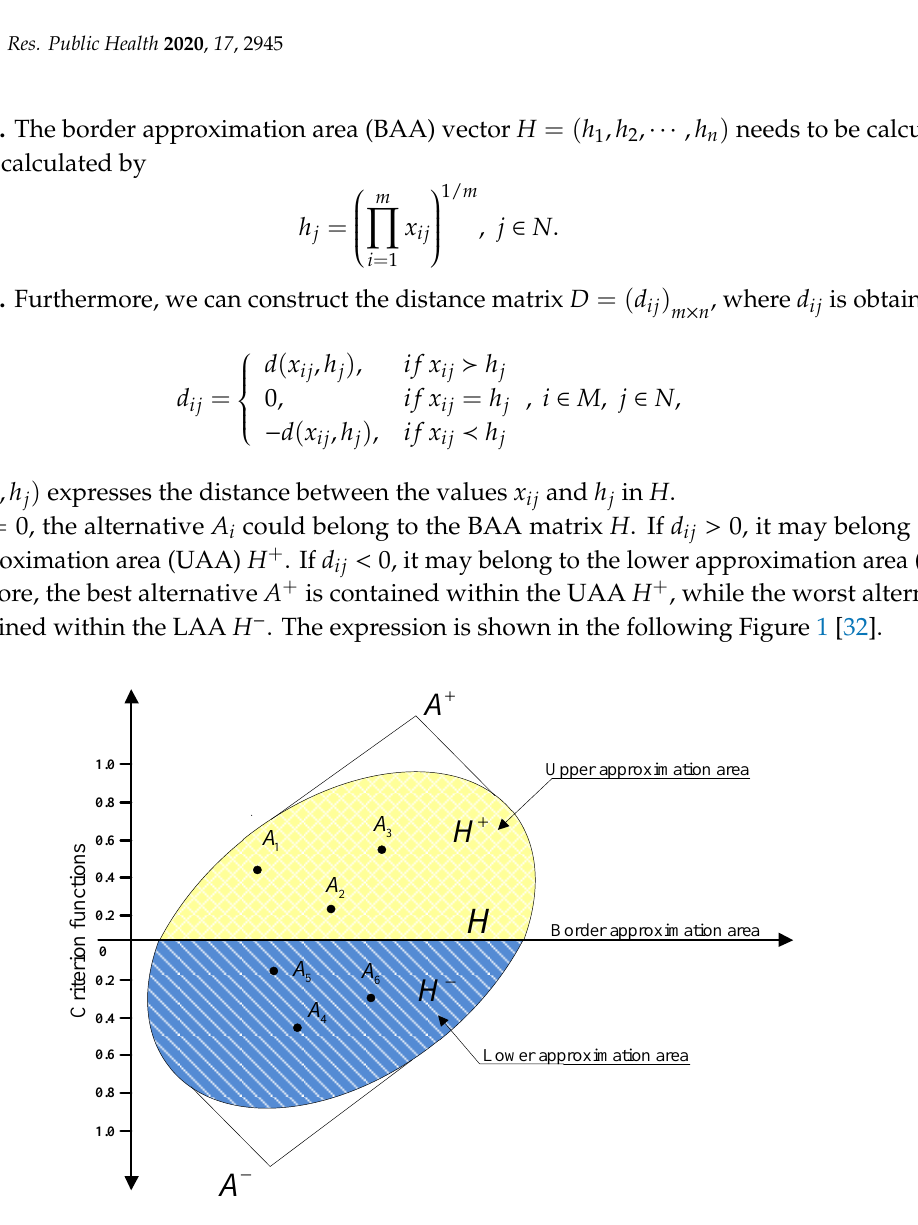
Figure 1. Presentation of the upper ( + H ), lower ( H ) and border ( H ) approximation areas.